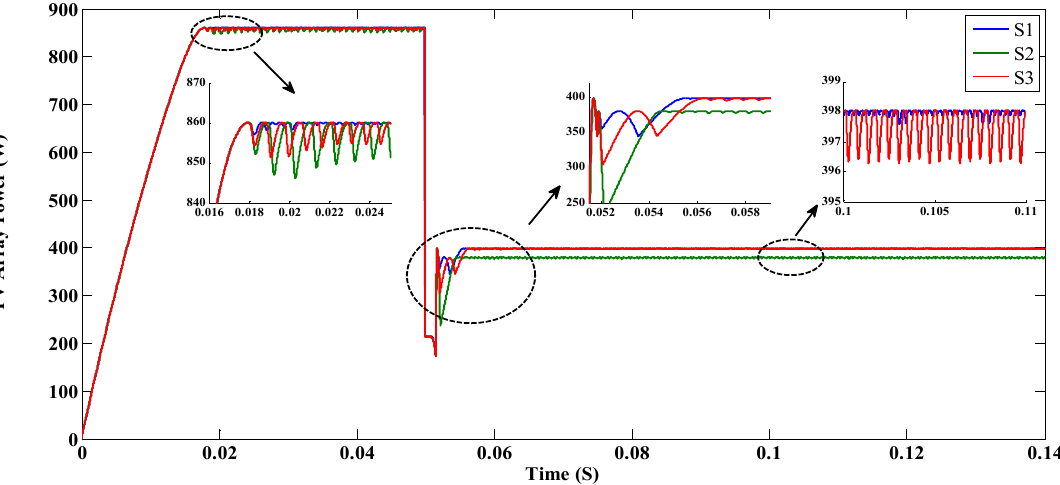
Figure 14. The PV output power for the scenario depicted in Figure 12b.